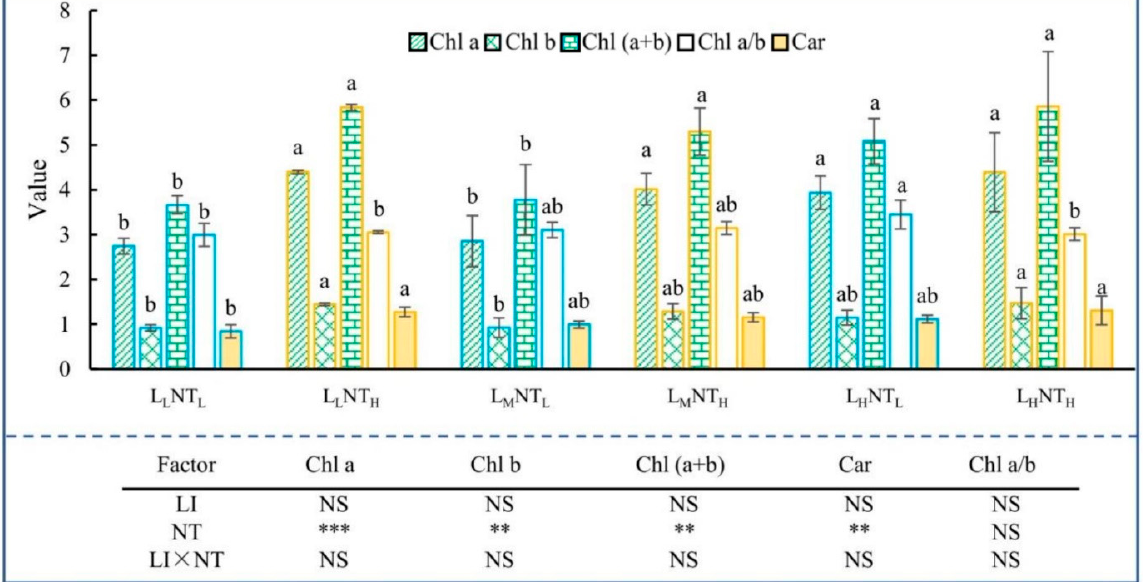
Figure 4. Effect of different light intensity (LI) and night temperature (NT) on photosynthetic pigment content of cherry tomato seedlings. Car, carotenoid; Chl, chlorophyll. The unit of photosynthetic pigments is (mg/g). Abbreviations of different treatments were as described in Figure 1. The symbol “NS”, “**” and “***” indicate no significance at p < 0.05, significant level at p < 0.01 and p < 0.001 by Duncan’s test, respectively. Different letters on bars for the same parameter indicate statistically significant differences ( p < 0.05).